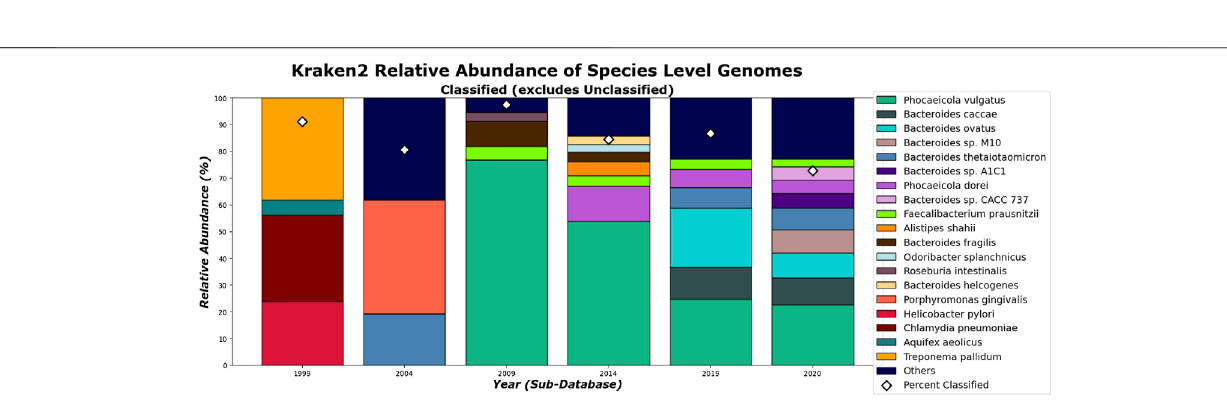
Frontiers in Signal Processing |